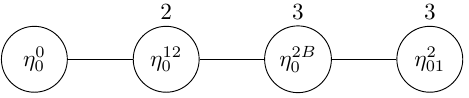
\ T \ V ( f ), Resolution 2 -model at S